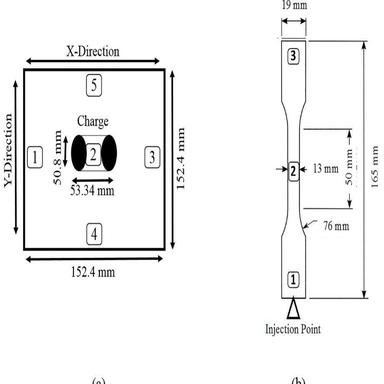
Samples locations for FLD calculations: (a) ECM, and (b) IM.